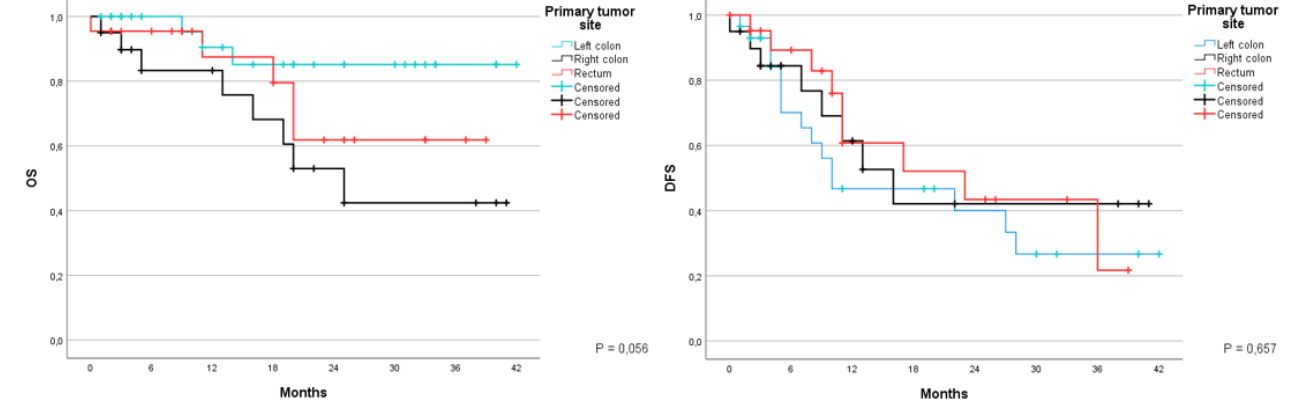
9 of 21 Figure 1. Kaplan-Meier curve for OS and DFS in patients who underwent liver resection for CRLM stratified based on the temporal presentation of metastasis (synchronous/metachronous). OS: over- all survival; DFS: disease free survival; CRLM: colorectal liver metastases. Based on the site of the primary tumor it was possible to organize patients into three groups: the left colon, the right colon and the rectum. Analyzing the different global sur- vival at 1 and 3 years of these groups it was noted that an OS of 90.5% and of 85.2% for the left colon, with an average of 37.5 months (95% CI 32.7 – 42), of 83.3% and of 42.4% for